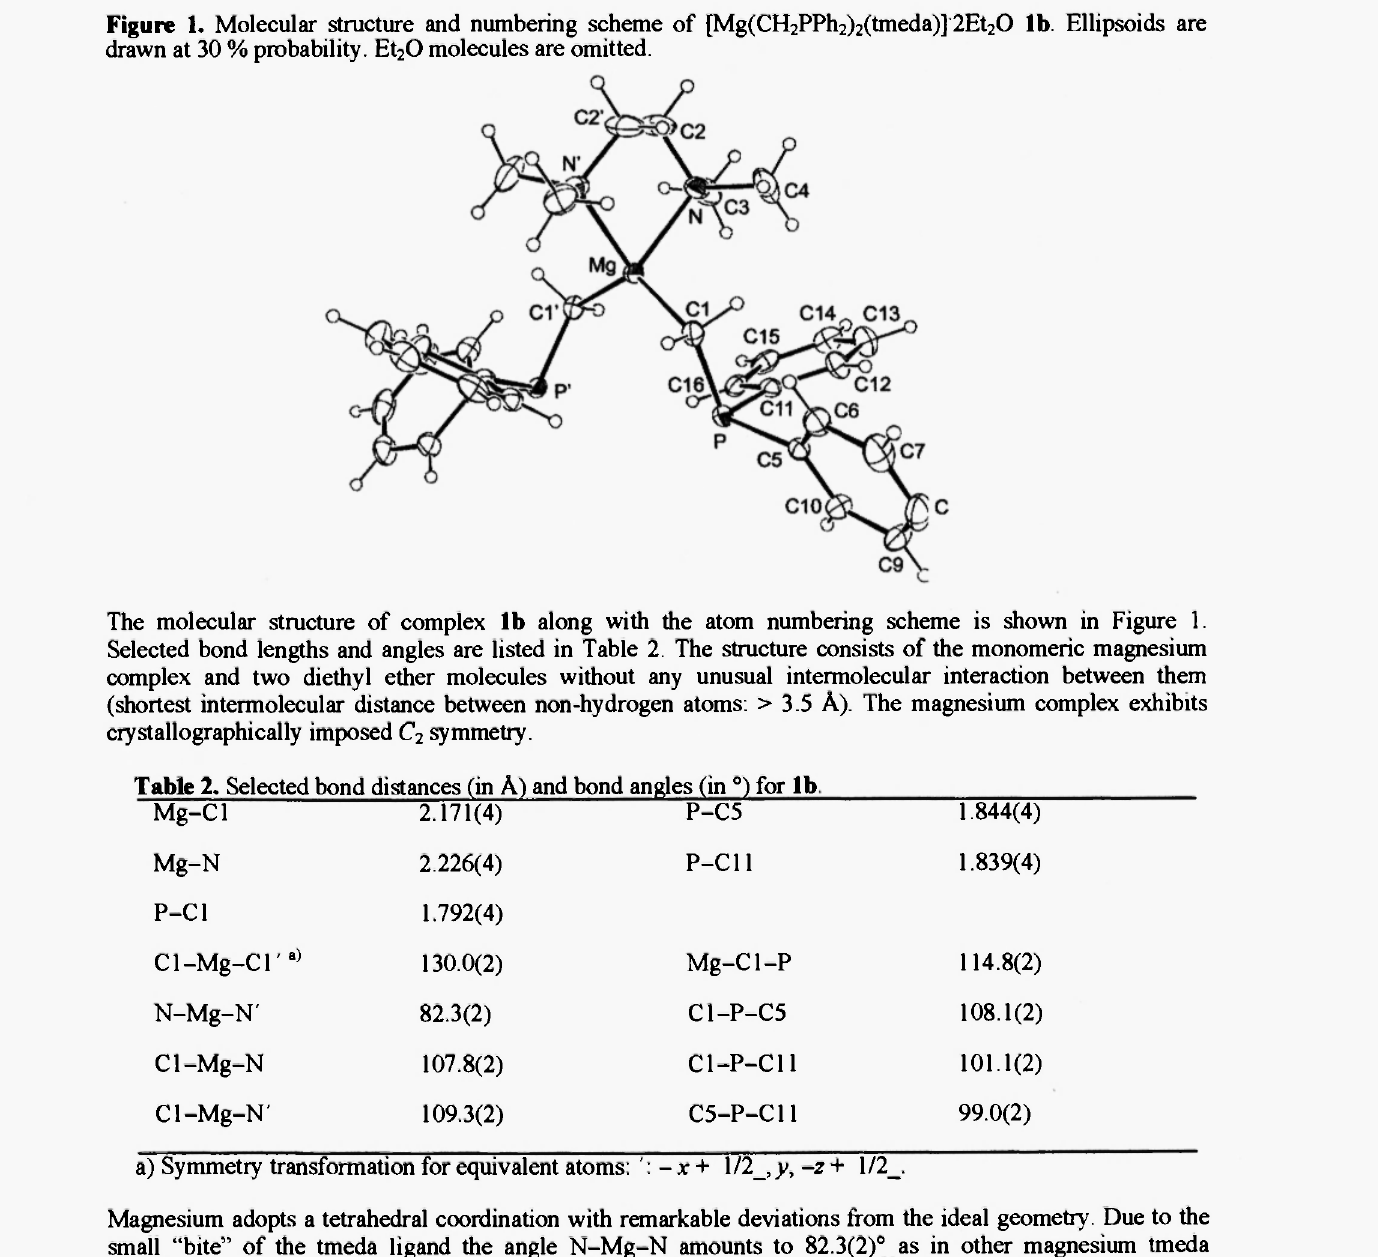
Figure 1. Molecular structure and numbering scheme of [Mg(CH 2 PPh 2 ) 2 (tmeda)] 2Et 2 0 lb. Ellipsoids are drawn at 30 % probability. Et 2 0 molecules are omitted.